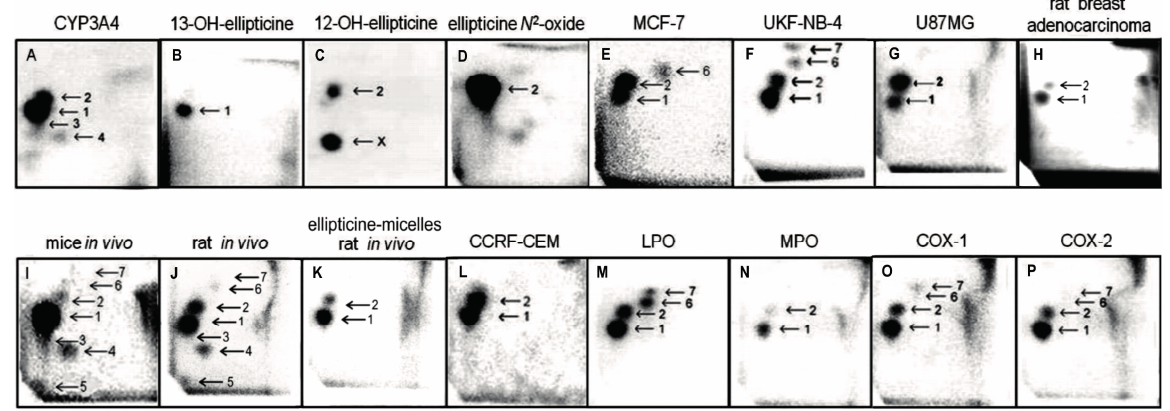
kilogram body weight (present study) ( J ); from liver DNA of Wistar rats treated i.p.